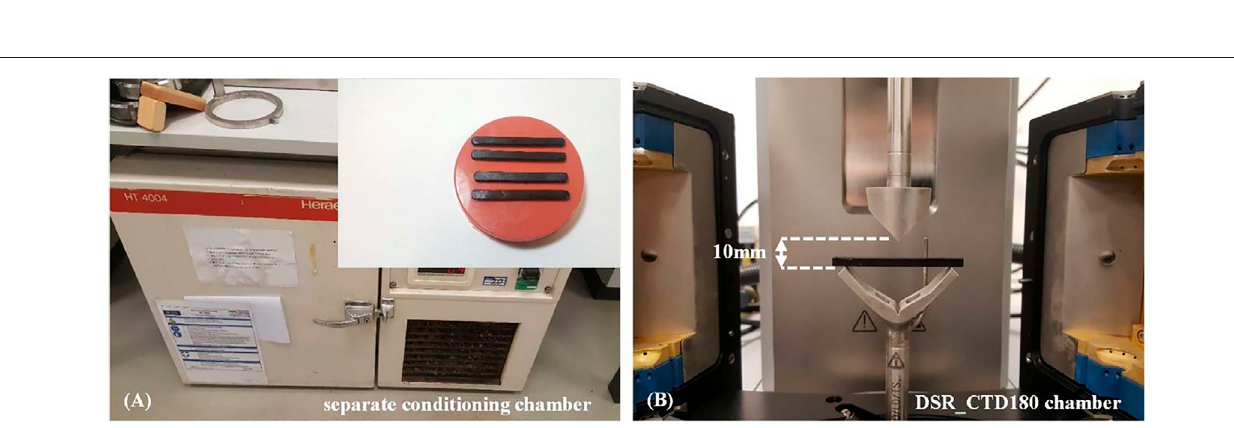
FIGURE 2 | Specimen preparation: (A) Pouring into silicone mold, (B) Trimming of specimen using a heated spatula, (C) Conditioning at − 18 ° C for 3 min, (D) demolding of specimen.